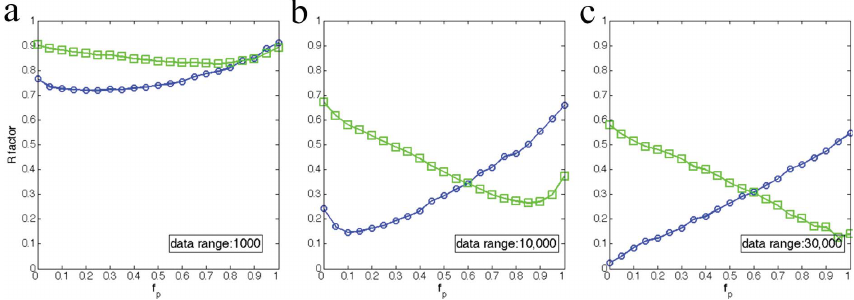
Figure 8 Measurable data range is critical to recover the molecular transforms. The data ranges are indicated in each plot. The partial unit cells cover 20% of the boundary layer, i.e. f p = 0.2. The corresponding recovered molecular transforms are shown in Fig. 9. The axes are defined as in Fig.